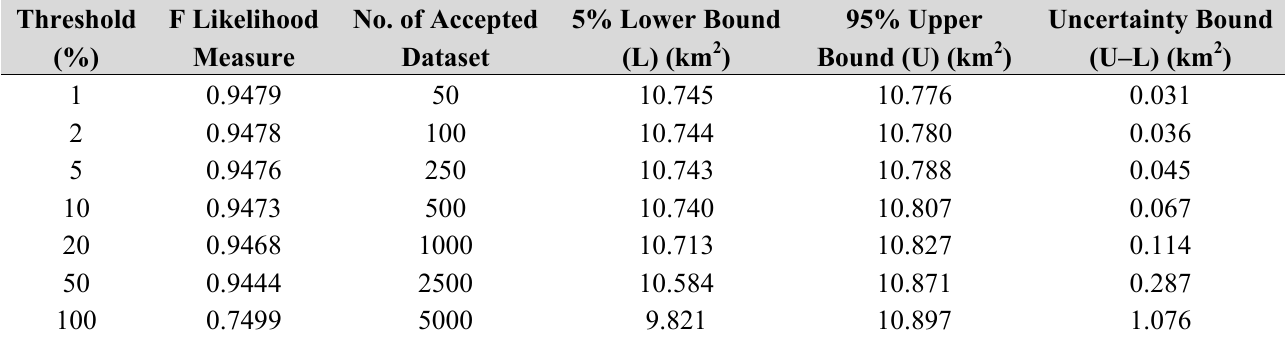
Table 4. F likelihood measure values, the number of datasets and the uncertainty bounds corresponding to the thresholds where a threshold indicates a percentage of total simulation (e.g., top 10% of best likelihood measures), the E likelihood measure shows the value calculated by the E likelihood function and the number of accepted datasets shows the number of datasets selected by the threshold. The uncertainty bound means 90% bounds between the lower 5% bound and the upper 95% bound for the inundation area.